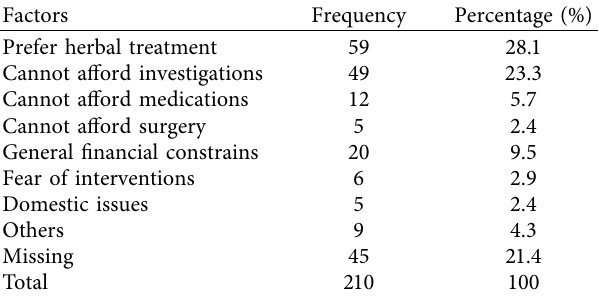
Table 4: Factors infuencing